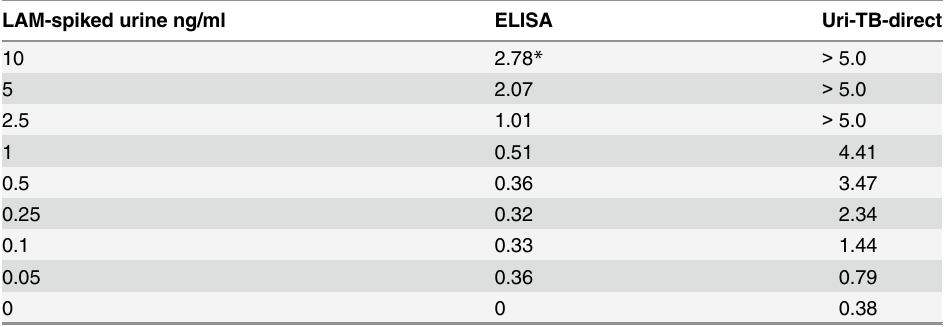
Results in optical density (OD) by the two different methods. The detection limit for the ELISA is (cid:1) 1 ng